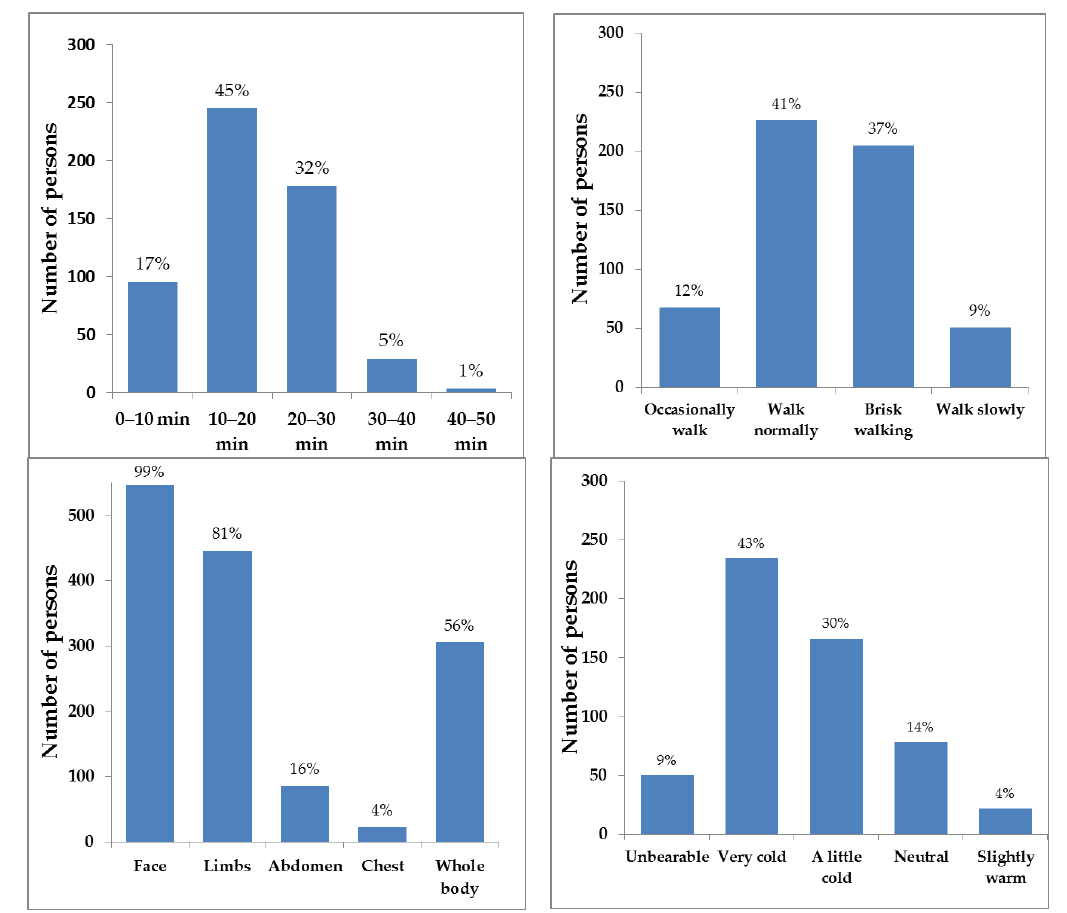
Figure 2. Statistical analyses of responses to questionnaire survey. Table 1. Two temperature conditions in the experimental setup.